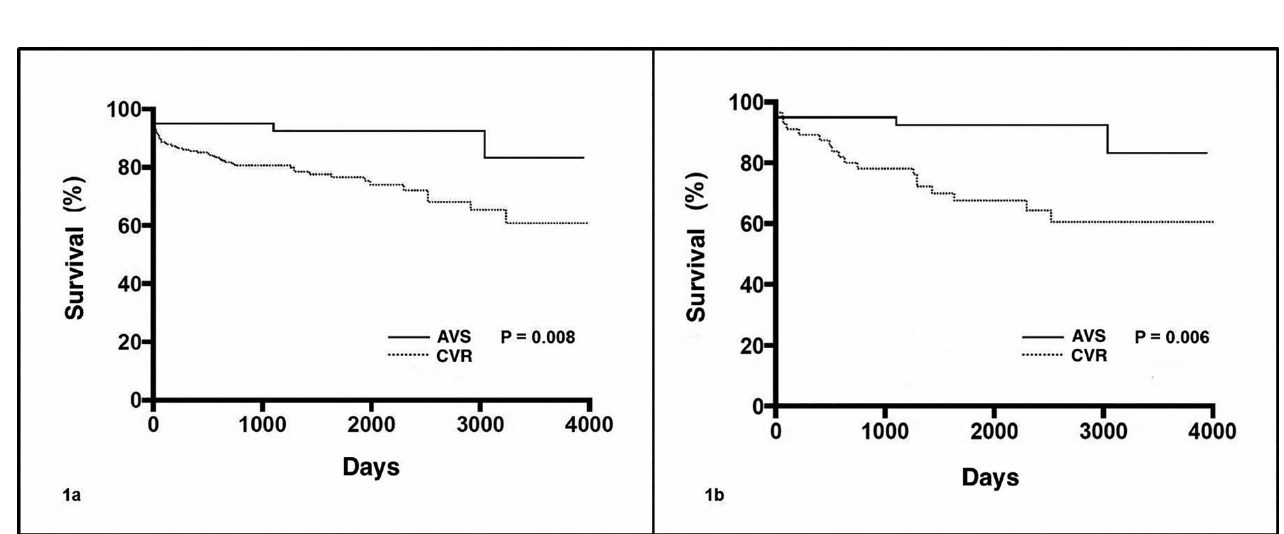
Fig. 1A - Survival curve of patients who underwent aortic root reconstruction via aortic valve-sparing operation (AVS) and composite graft- valve replacement (CVR) techniques. 1B - Survival curve of propensity score matched patients who underwent aortic root